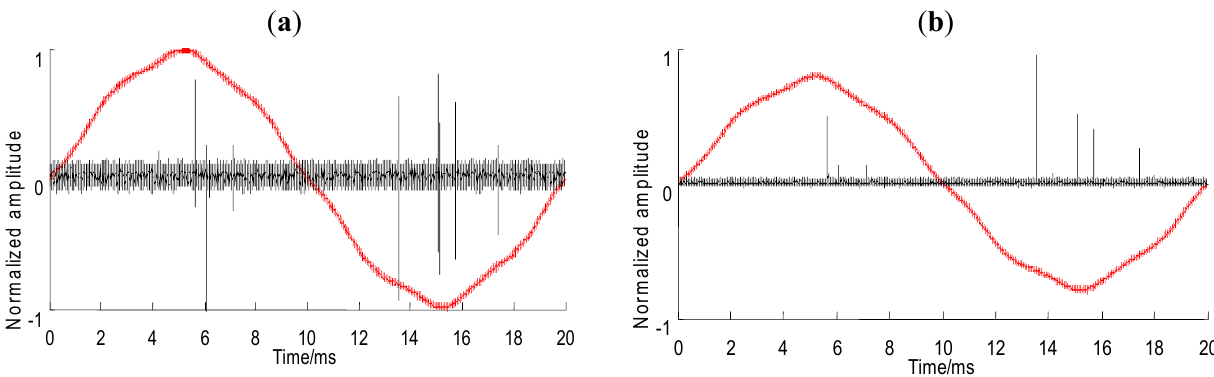
Figure 9. Contrast of PD signals in an industrial frequency cycle; ( a ) PD UHF signal; ( b ) PD optical signal.